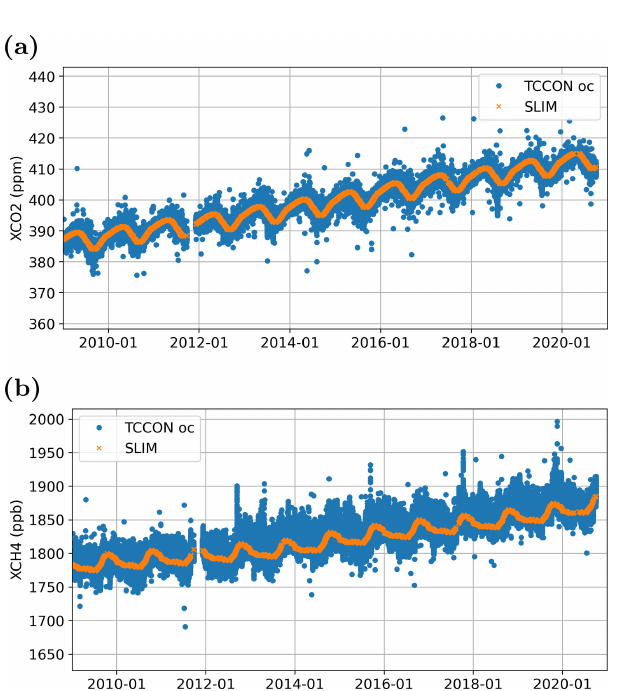
Figure A6. Time series of XCO 2 (a) and XCH 4 (b) from TCCON and SLIM at Lamont (station code